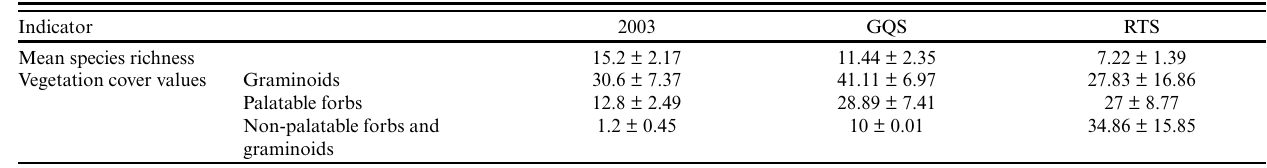
Table 6 . Species richness and vegetation cover on summer pasture at baseline in 2003, and under the community-based grazing quota system (GQS) and rangeland transfer system (RTS) in 2014 (n = 9). “±” represents standard deviation.